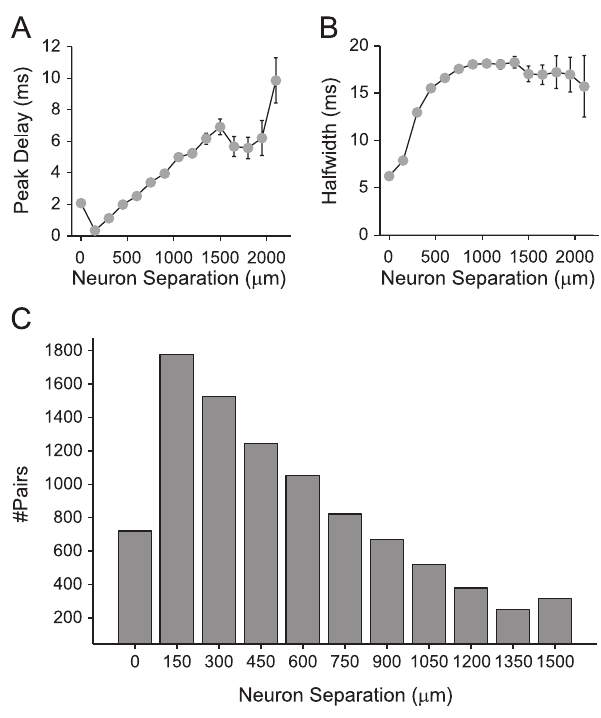
Figure 6. Temporal interaction parameters as a function distance between neurons. (A) Population data for peak delay versus neuron separation. Cross-covariance function peak delay increases with increasing cortical distance between functionally connected neurons. Data are mean + / 2 S.E.M. (B) Population data for halfwidth versus neuron separation. Halfwidth increases with neuron separation. Data are mean + / 2 S.E.M. (C) Frequency histogram of neuron separation for functionally connected